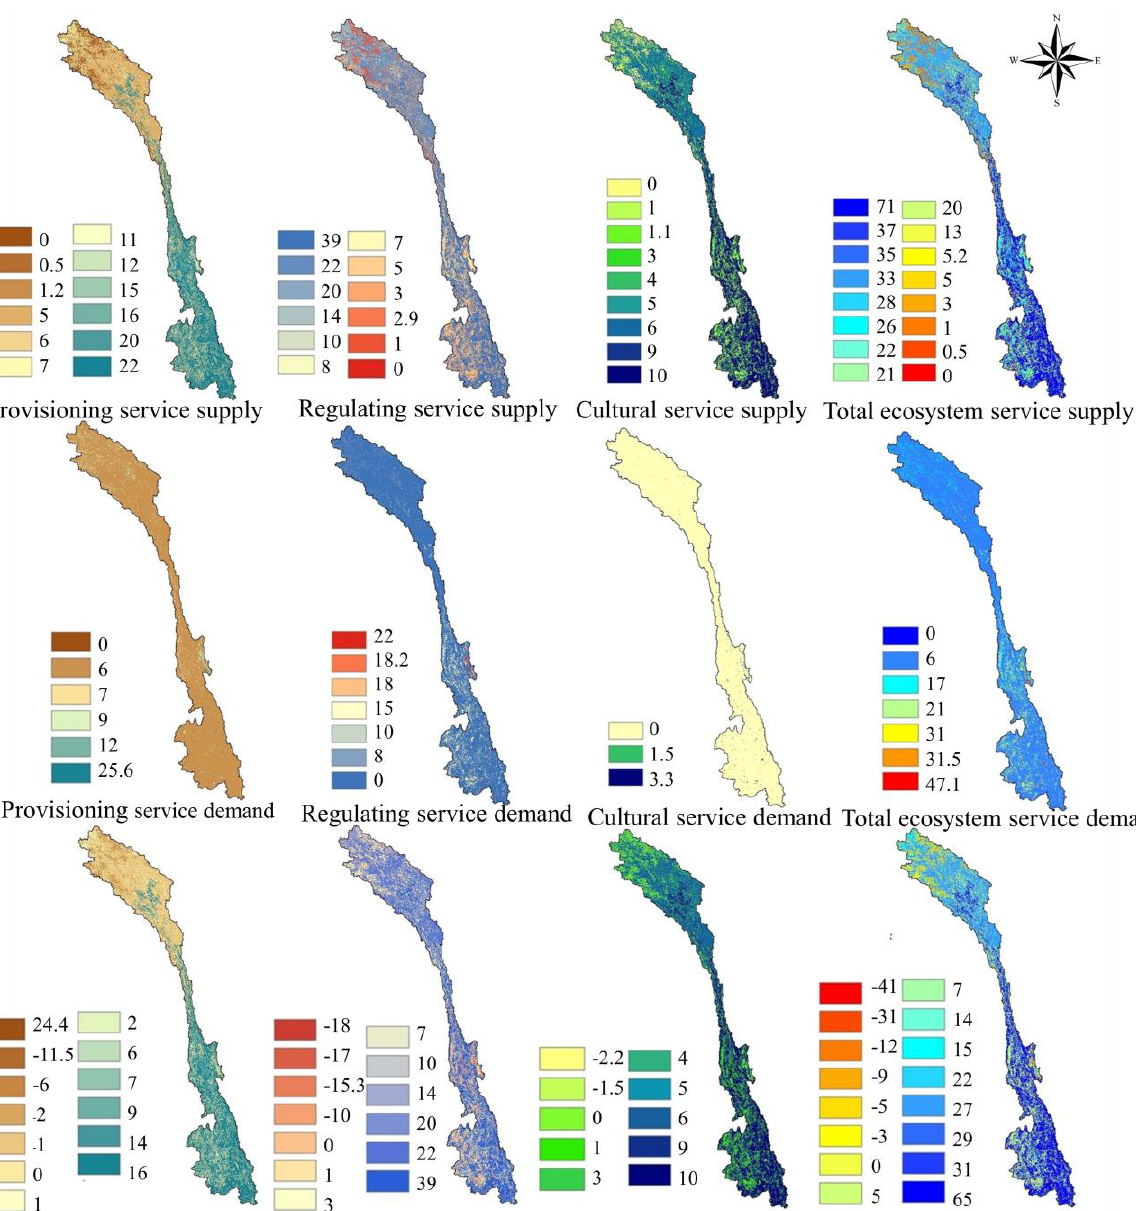
Figure 4. Spatial distributions of ESs in the Lancang river valley.